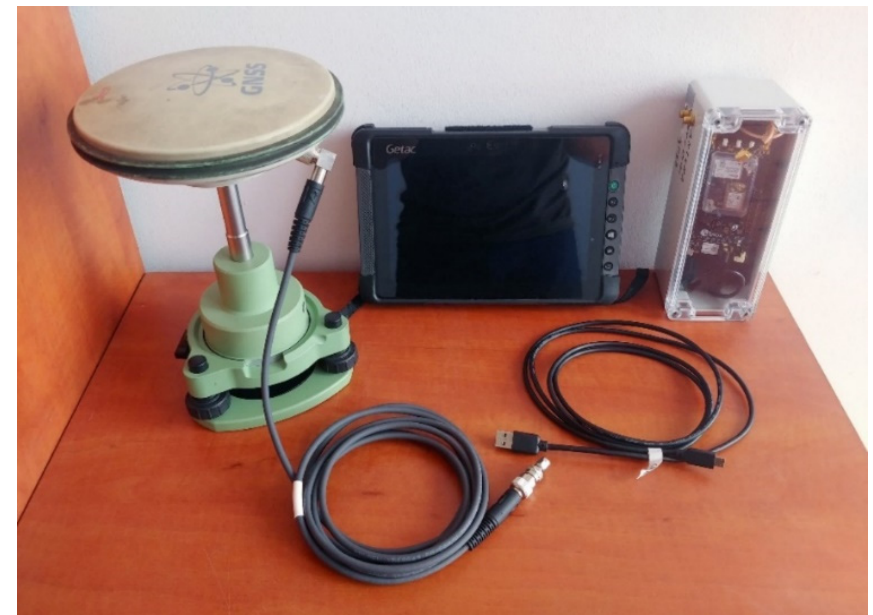
Figure 4. U-blox C099-F9P application board in self-made case with powerbank, Getac T800G2 rug-